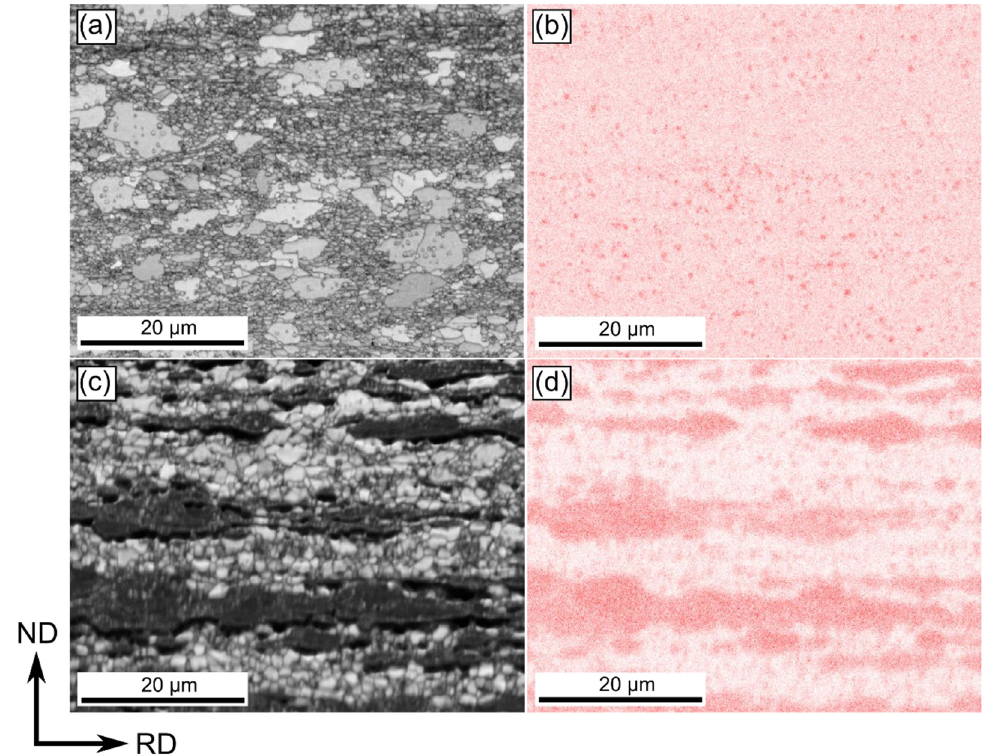
Figure 2. SEM/EBSD image quality map and corresponding Cu distribution map of samples